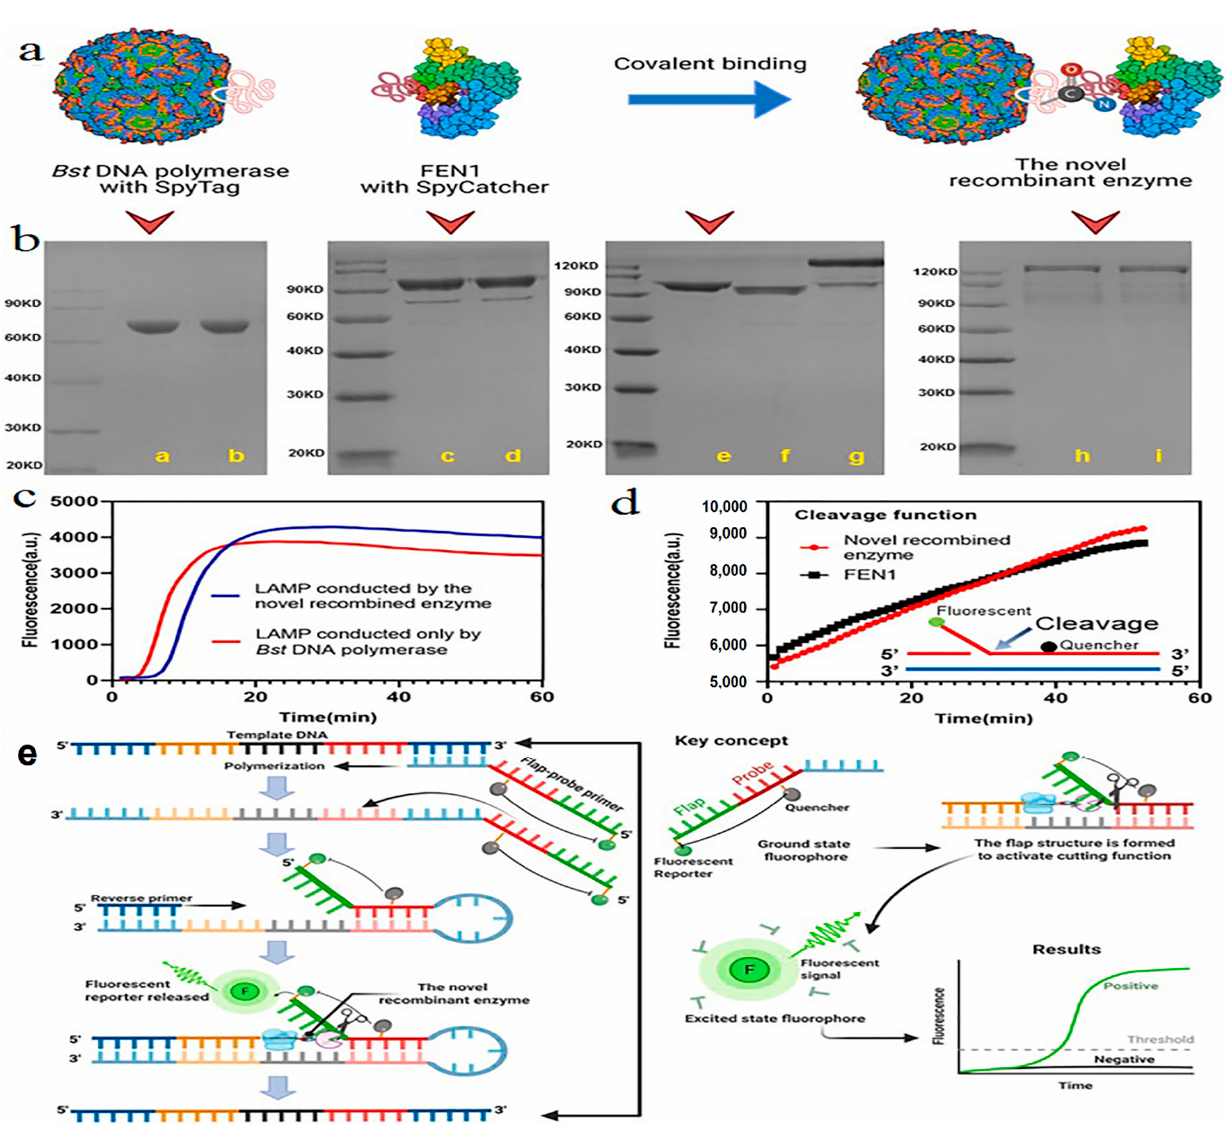
Figure 3. The recombinant FEN1- Bst DNA polymerase and a schematic illustration of flap-probe-based isothermal nucleic acid amplification method for rotavirus genome detection. ( a ) Schematic presentation of recombination through covalent binding of the SpyTag/SpyCatcher system. ( b ) SDS- PAGE confirmation of Bst DNA polymerase with SpyTag, FEN1 with SpyCatcher, and the new re- combinant enzyme: lane a and b are reduced and non-reduced Bst DNA polymerase (SpyTag) pro- tein, respectively; lane c is reduced FEN1 (SpyCatcher) protein while lane d is non-reduced one; Bst DNA polymerase (SpyTag) in lane e and FEN1 (SpyCatcher) in lane f form the novel recombinant enzyme protein (lane g); and lane h and i indicate novel recombinant enzyme protein. ( c ) Common LAMP reaction utilizing the novel recombinant enzyme. ( d ) Cleavage reaction of the flap structure using the novel recombinant enzyme to release fluorescent reporter that can be detected in real- time. ( e ) Overview of the mechanism and key concepts such as polymerization, flap structure crea- tion, cleavage to release the fluorescent reporter, and real-time detection by analyzing fluorescent signal. Notes: LAMP, loop-mediated isothermal amplification. This figure was reprinted with per- mission from ref [115] Copyright 2022, Elsevier.